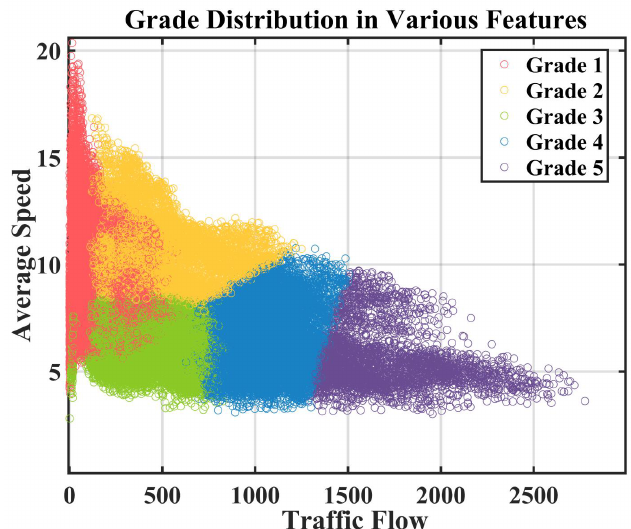
Figure 2. Distribution of sample points under different features after SOM clustering.